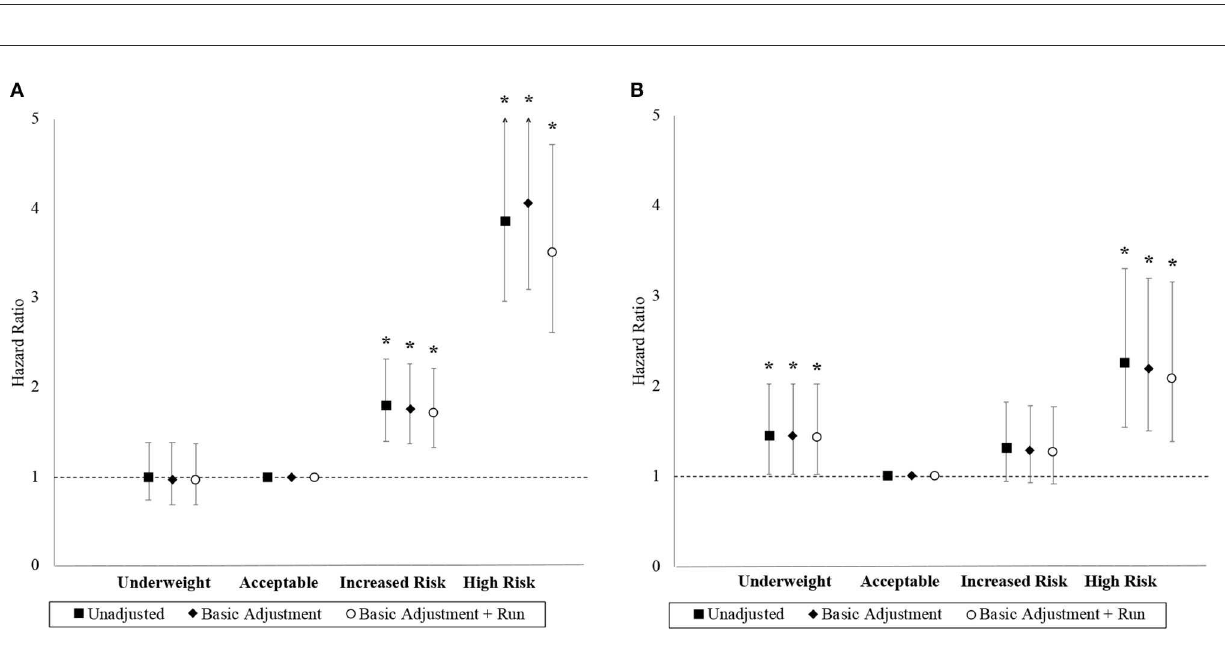
FIGURE3 Hazard ratios with 95% confidence interval by BMI category. Panels (A, B) correspond to the MACE and ACM outcomes, respectively. Basic adjustments also included the year of BMI measurement and age at time of entry into the study period as predictors in the models. Models were further adjusted for the 2.4km run-time. An asterisk (*) denotes a hazard ratio that is significantly different from 1 (i.e., p <